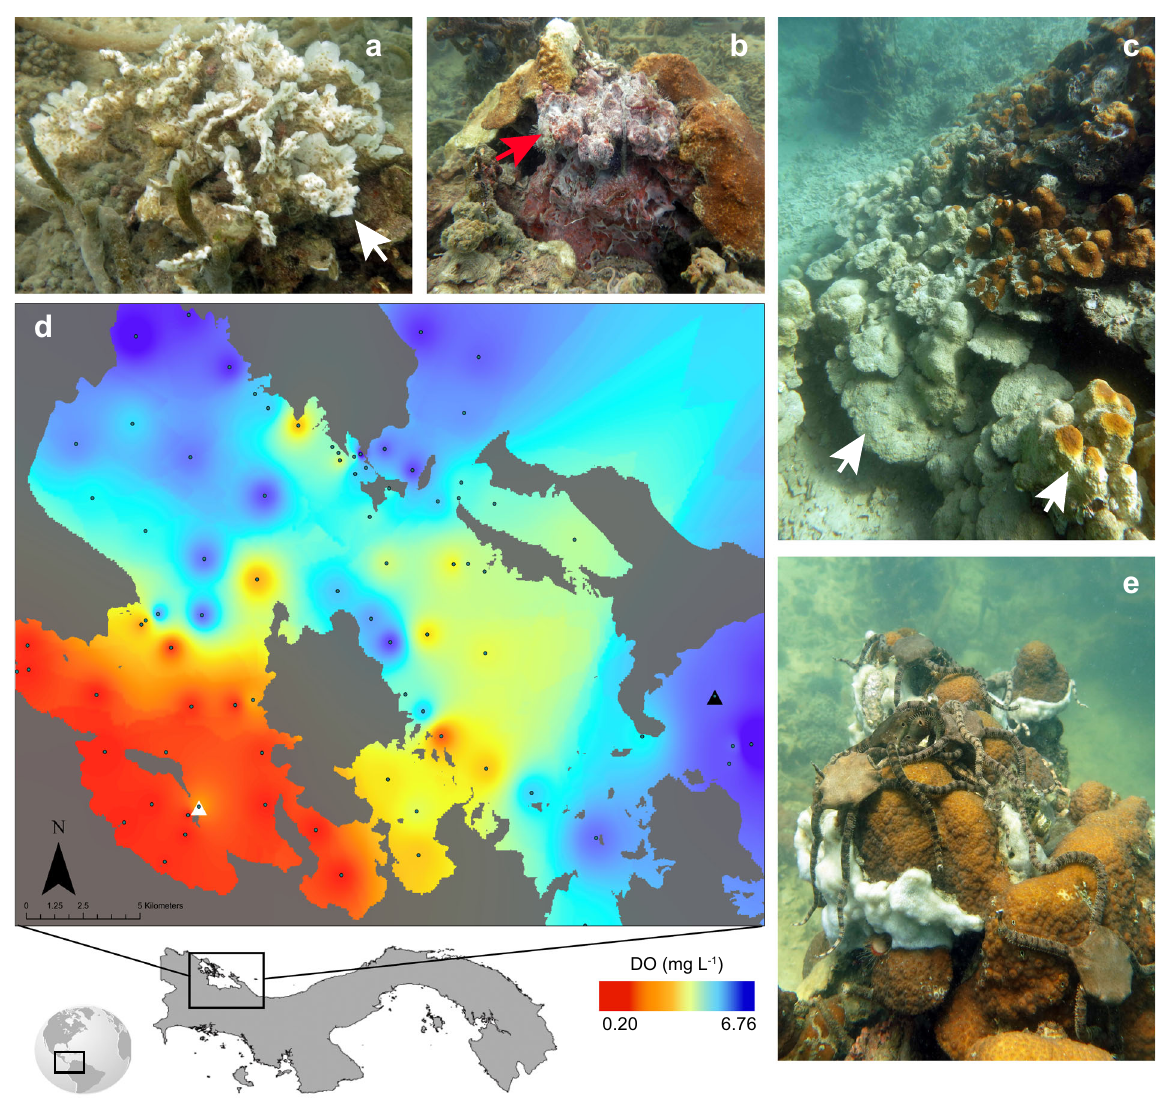
Fig. 1 Dissolved oxygen concentrations and responses of coral reef taxa during the 2017 deoxygenation event in Bocas del Toro, Panama. a Coral bleaching (white arrow) was evident in corals at the impacted site (Cayo Roldan, white triangle) during the 2017 event, including the lettuce coral Agaricia tenuifolia . Below the oxycline in hypoxic waters, b microbial mats diagnostic of anoxic conditions, comprised of thin, white fi laments (red arrow), were abundant, and c coral bleaching typically progressed from the bottom to the top of boulder corals (white arrow). d Map of Bahía Almirante illustrates DO concentrations at the benthos 6 days after initial detection of the event (depths ~3 – 20 m), with sampling stations noted as black dots. An unaffected coral reef (Cayo Coral, black triangle) located outside Bahía Almirante was used as a reference site. e Below the oxycline at the impacted site, invertebrates, including cryptic brittle stars, congregated on the tops of boulder